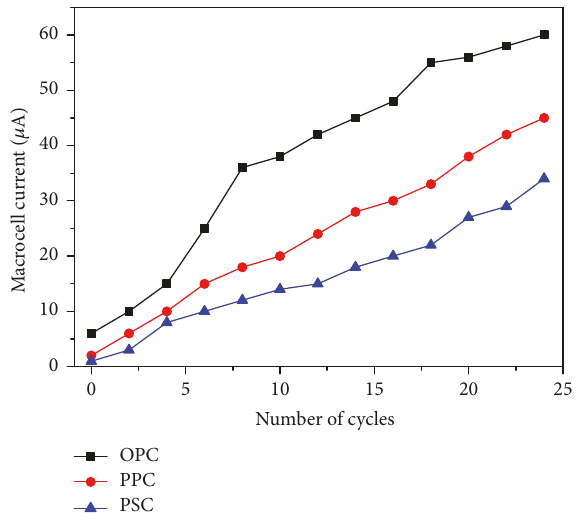
Figure 15: Total integrated current versus number of cycles of exposure for rebar in OPC, PPC, and PSC M40 grade concrete types (90-day cured specimens) under macrocell